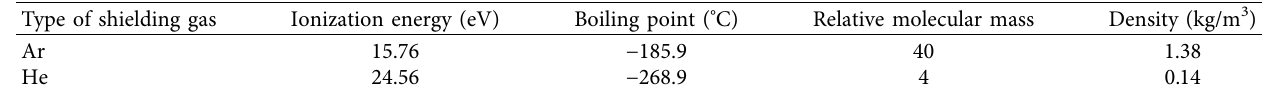
Table 2: Basic physical properties of shielding gases.